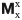
Distribution of half-sarcomere lengths, lhs, in the cubic muscle specimen for different muscle lengths ranging from L/L0 = 1.1 to 1.7 during fixed-length contractions of models Mxx, MFv, MATI, and MATIFv.Results after 2.5 s are displayed (steady-state conditions), where the results of models Mxx and MFv (left), as well as those of MATI and MATIFv(right) coincide.